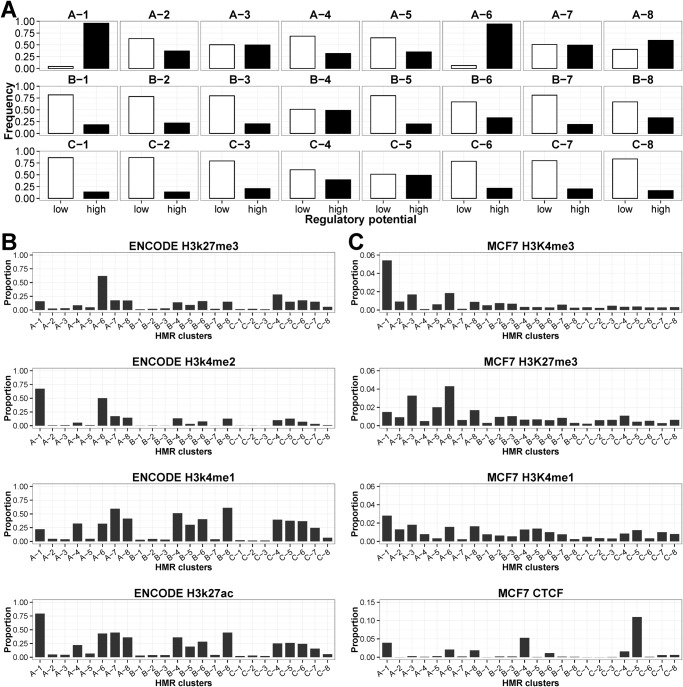
Association of HMRs with cis-elements and various histone modifications.(A) Proportion of different clusters of HMRs with “low” and “high” regulatory potentials. “Low” potential denotes HMRs that intersect less than four regulatory features, whereas “High” potential HMRs are those that intersect four or more features. A total of eight features were used in the analysis, they are: FANTOM5 TSS, FANTOM5 enhancers, CGI, ENCODE TFBS, ENCODE DNase I hypersensitive sites, MCF7 MNase hypersensitive sites. MCF7 HpaII hypersensitive sites, and RNA PolII binding sites from MCF7 and ENCODE. (B) Proportion of HMRs in each cluster that harbored high levels of ENCODE H3K27me3, H3K4me1, H3K4me2 and H3K27ac. (C) Proportion of HMRs in each cluster that harbored high levels of H3K27me3, H3K4me1, H3K4me3 and CTCF in MCF7. For each histone modification, the HMRs whose score is in the top 20% were considered as having high levels.